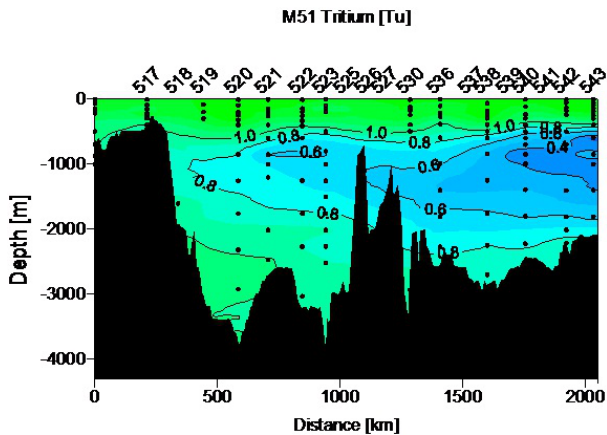
Fig. 3. The 2001 Meteor tritium section with the decay correction omitted. For the actual section and color bar, see Fig.